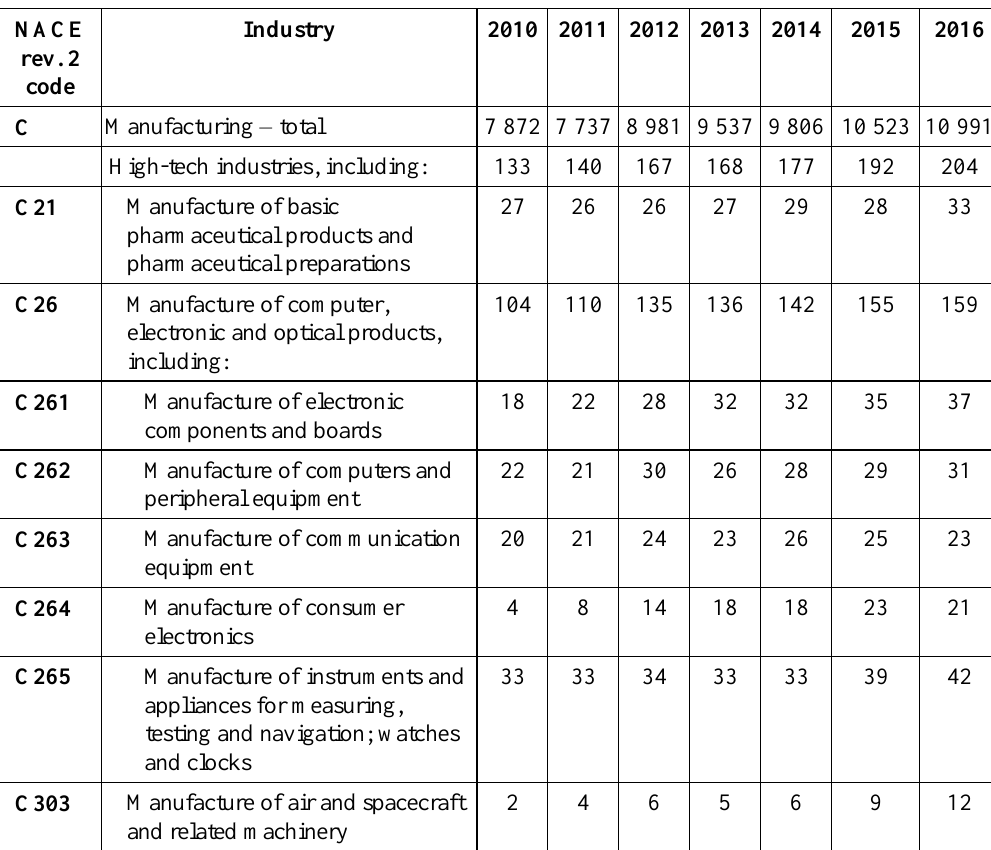
Table 1. Number and Dynamics of Enterprises in High-Tech Industries in Latvia (CSB,